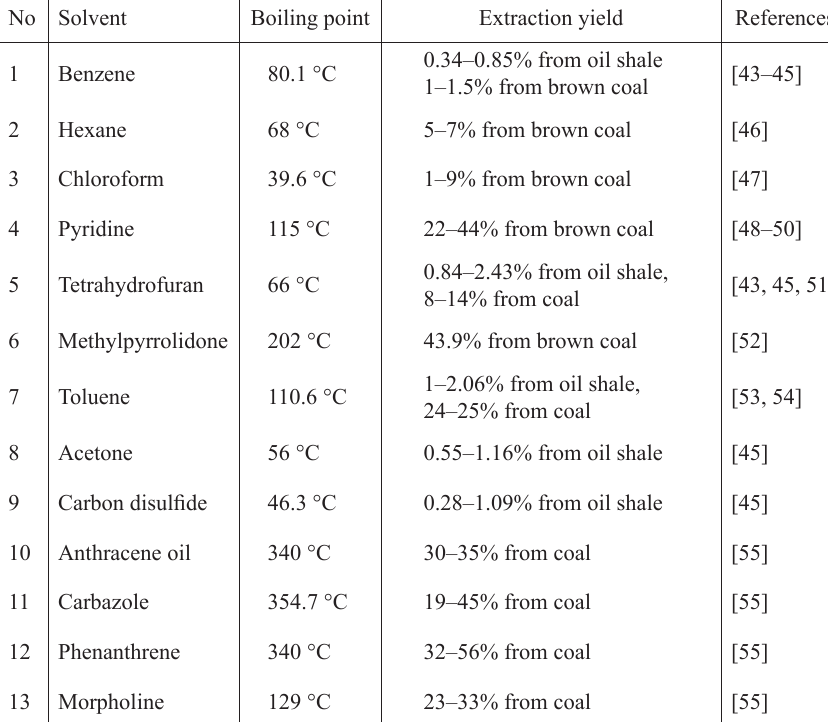
Table 1. Extraction at boiling point of solvents No Solvent Boiling point Extraction